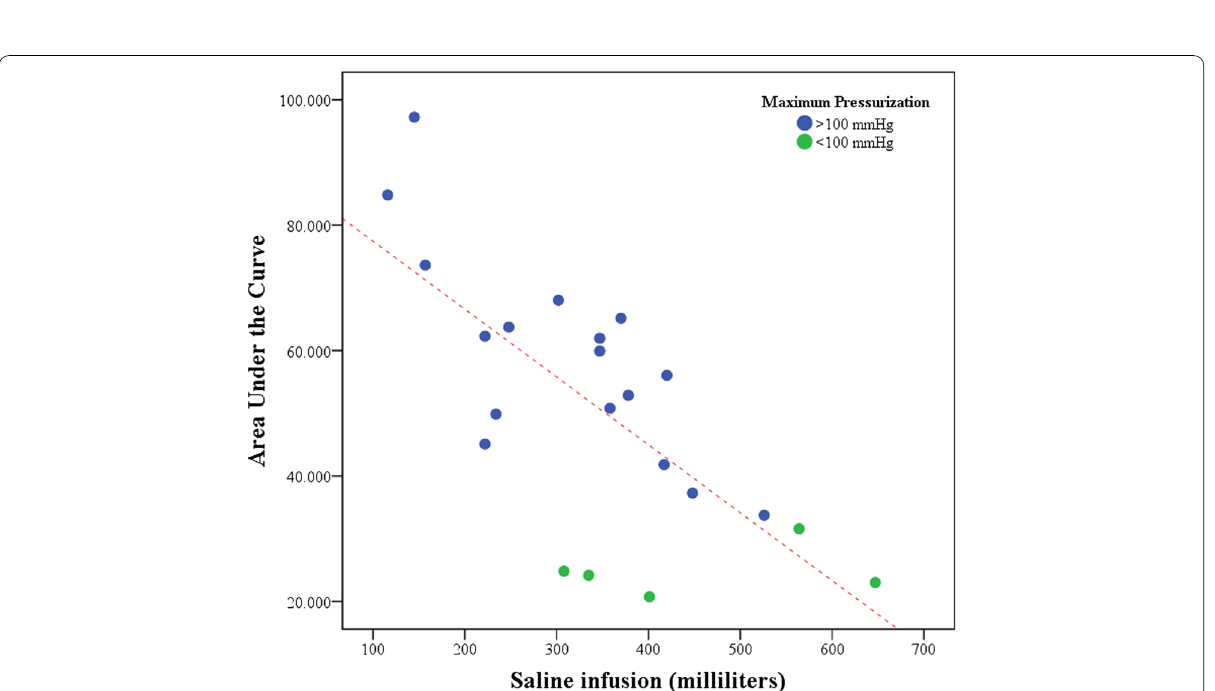
Fig. 5 Correlation between the amount of saline infusion and the overall change in ICP values (Area Under the Curve). A statistically significant negative relation was found amongst all 22 trials ( r 0.709, p < 0.01). Also, the mean volume of saline infusion required in runs that exceeded = − 100 mmHg was significantly lower compared to those which did not exceed this threshold ( p =